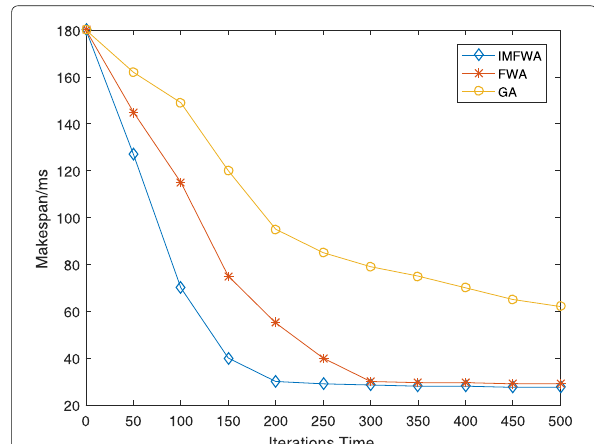
Fig. 2 Performance comparison results of the three algorithms